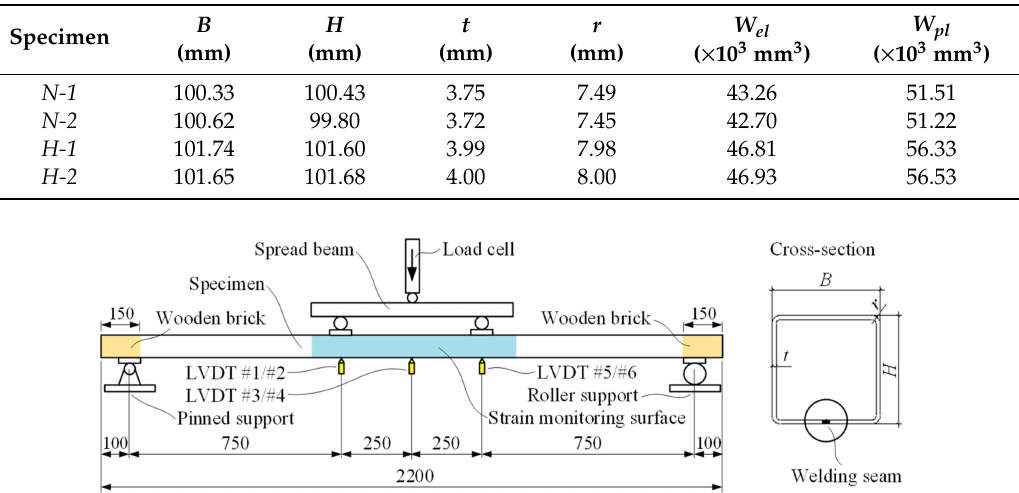
Table 3. Geometry parameters of the beam specimens.